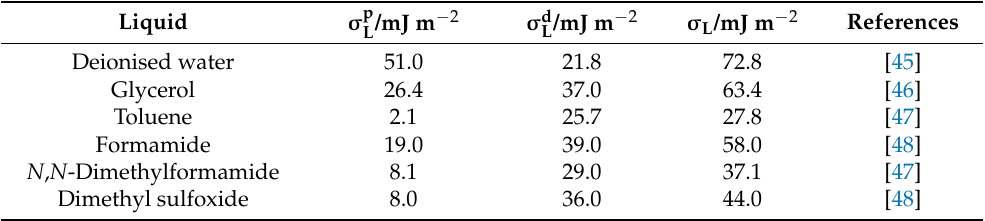
Table 2. Liquids used for tensiometric measurements and the values of the polar and dispersion components of the surface tension of liquids at 25 ◦ C.